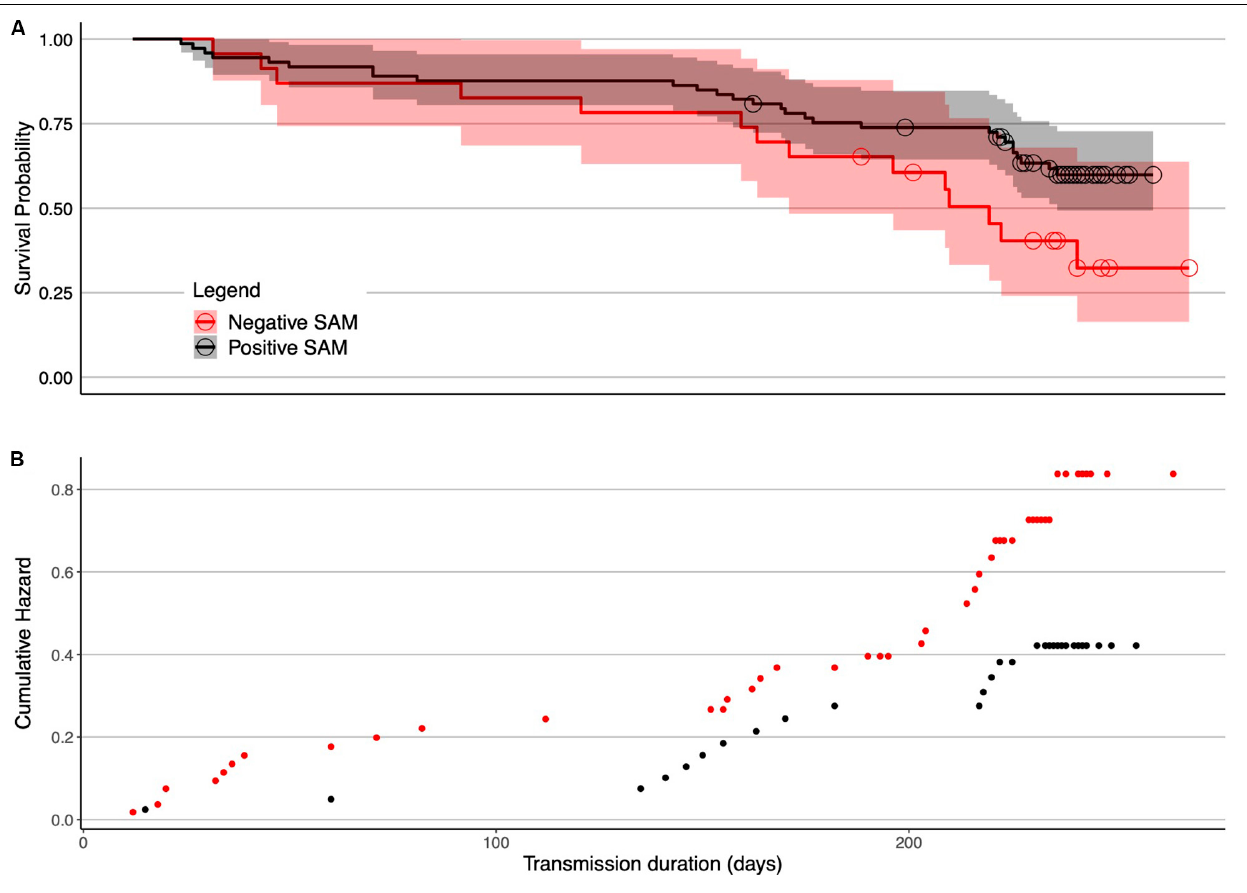
FIGURE 5 | Female SAM survival curves in isolation of other non-significant factors. (A) Deployments in positive SAM years were associated with reduced tag failure probabilities in females. Separation of tag failure probabilities between the two groups was evident, beginning around 70 days. For females, there were